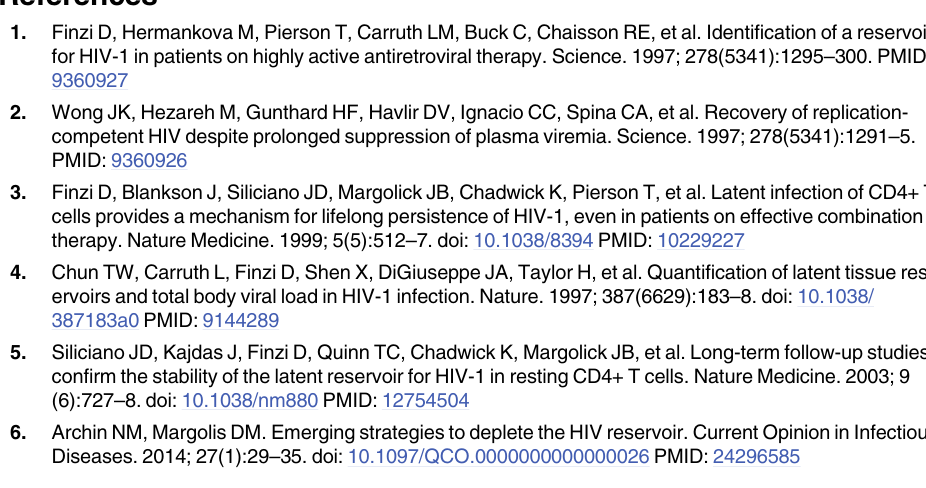
S5 Table. Raw data for experiments with total CD4+ T-cells. S6 Table. Raw data for experiments with